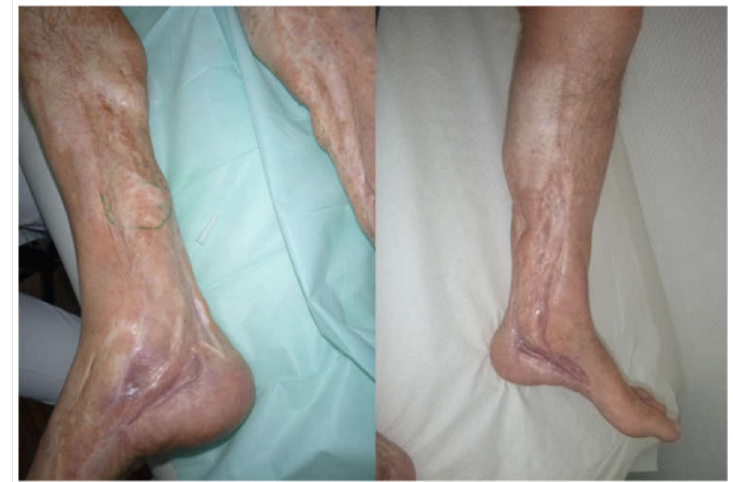
Figure 1. Example of a potential indication for a neurotized flap. Patient is suffering from severe tarsal tunnel syndrome and has undergone multiple operations, leaving a scarred and hardly covered environment for the nerve, resulting in severe neuroma pain.